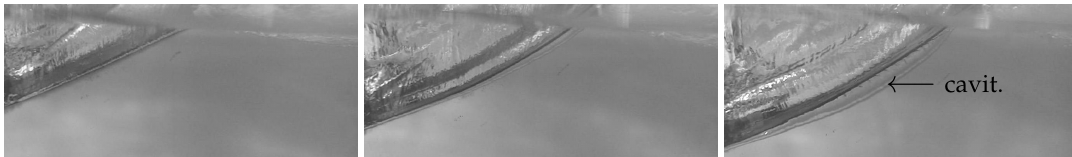
Figure 12. Evolution of the water entry of a wedge (V) ( β = 20 ◦ ) entering the water at 53.3, and 66.6 ms from the impact. The arrow highlights the cylindrical front of the cavitating area.